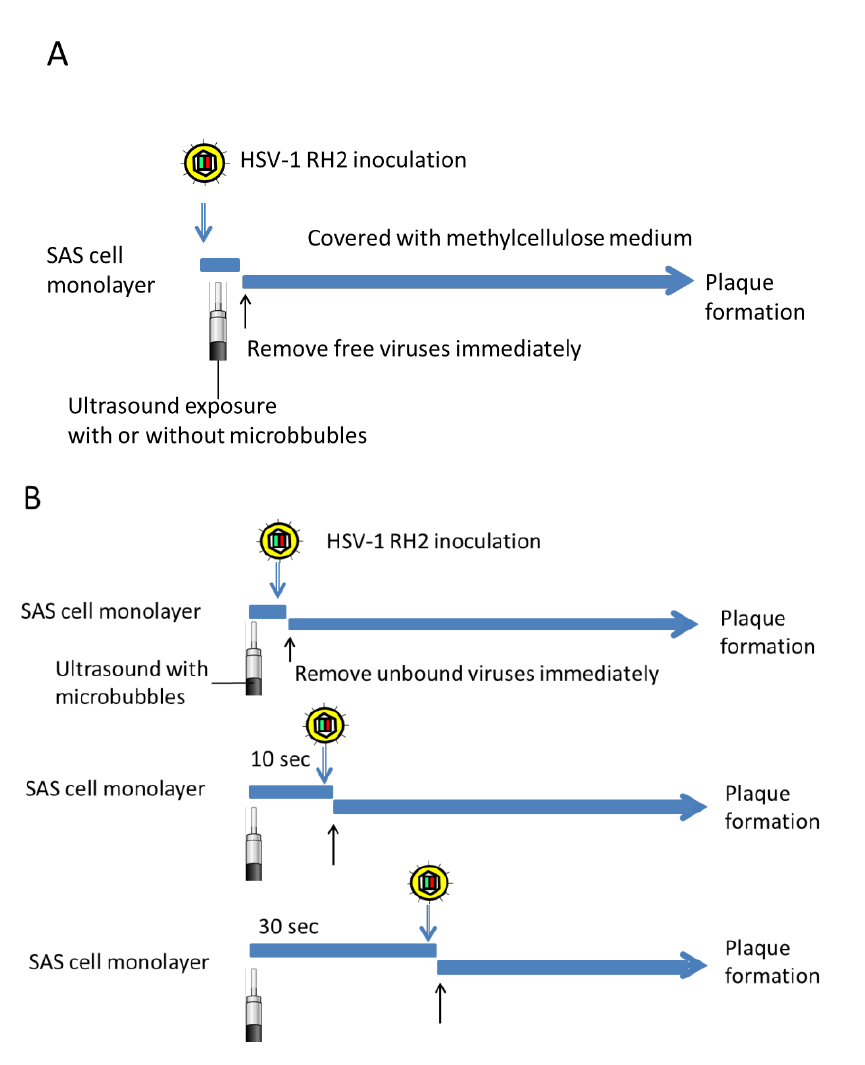
Figure 1. Experiments to determine the ultrasound-mediated increase of virus entry estimated by plaque numbers. ( A ) SAS cell monolayers were inoculated with HSV-1 RH2, with or without microbubbles, and then exposed to ultrasound for 10 s at room temperature. Cell monolayers were immediately washed with PBS to remove any unbound virus, covered with medium containing 0.3% methylcellulose and cultured at 37 °C for the plaque assay; ( B ) SAS cells were treated with ultrasound for 10 s in the presence of microbubbles at room temperature. At 10 to 1200 s after ultrasound exposure, cells were inoculated with HSV-1 RH2. They were immediately washed with PBS to remove unbound virus and covered with medium containing 0.3% methylcellulose for the plaque assay. To determine the interval during which virus entry was permitted without an adsorption time, cell monolayers were treated with ultrasound in the presence of microbubbles at room